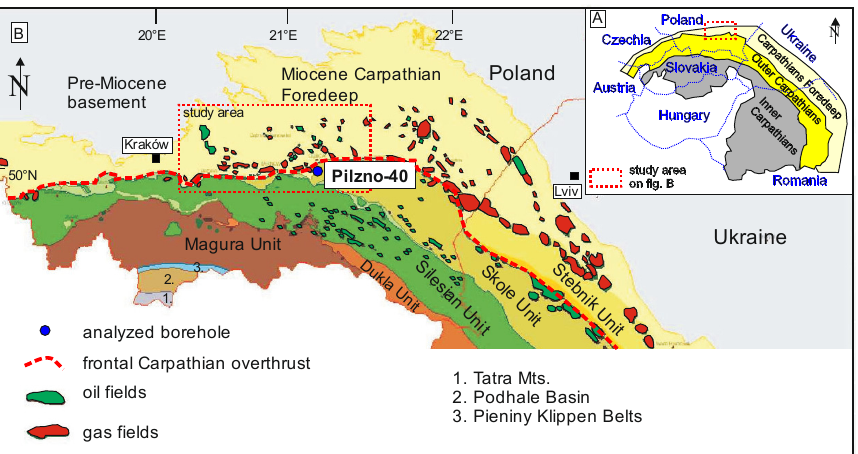
Figure 1. Location of the study area including oil and gas fields overlaid on simplified geology ( A , B ); modified from [3,4,14].